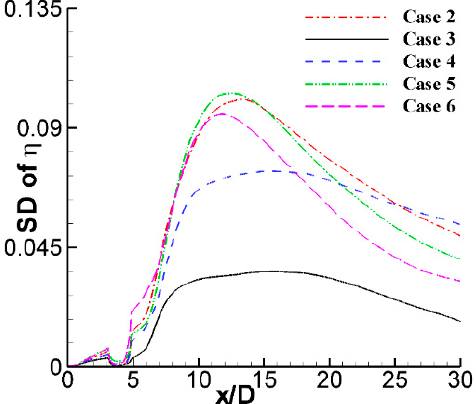
Figure 15. Spanwise-averaged standard deviation of the film cooling effectiveness of Case 2–6.